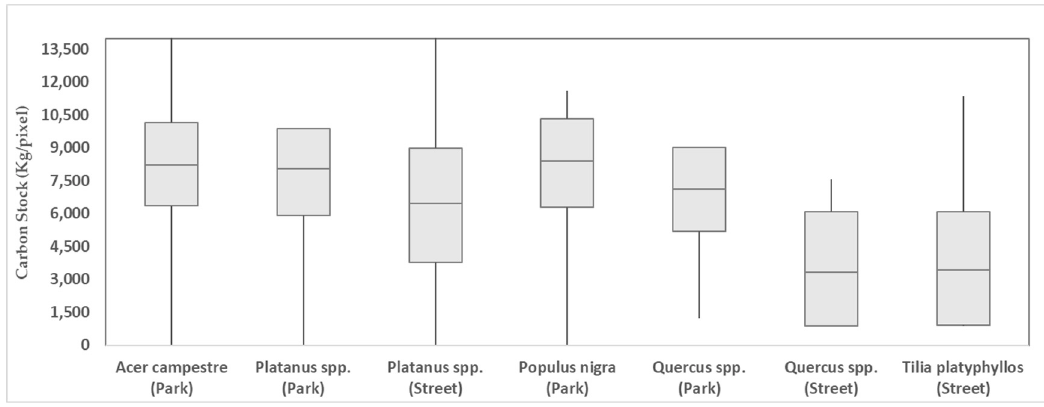
Figure 11. The overall results of the computed CS mapping in QGIS for all the dominant species. For the CS mapping validation, seven randomly selected plots were considered. Considering all the dominant species, four plots from the streets and another three plots were selected from the parks.